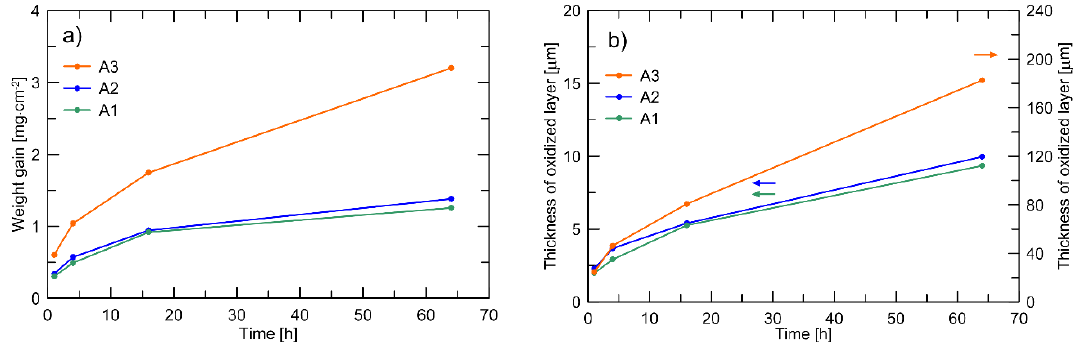
Figure 3. The weight gain ( a ) and the thickness of the oxidized layer ( b ) for grades A1, A2 and A3 with Al contents 5.5 wt.%, 2.0 wt.% and 0.3 wt.%, respectively.